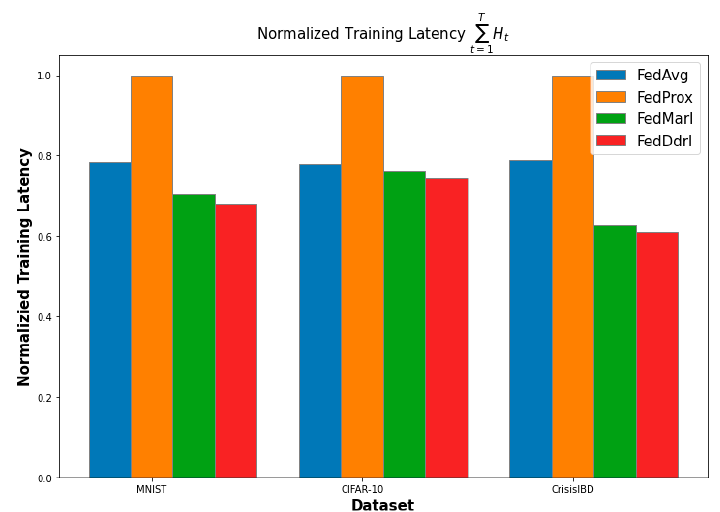
Figure 8. Normalized training latency of each FL algorithm.